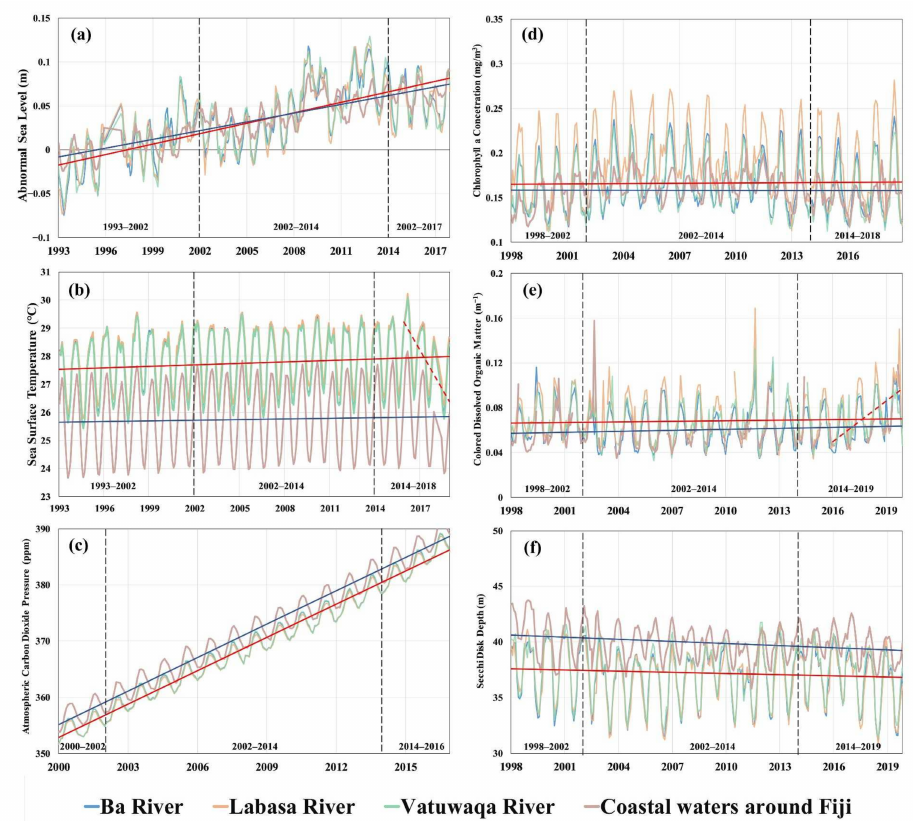
Figure 6. Anomaly chart of long-term variation in water environment parameters: ( a ) Sea-level anomaly; ( b ) Sea-surface temperature; ( c ) Atmospheric carbon dioxide pressure; ( d ) Chlorophyll a concentration; ( e ) Absorption of colored dissolved organic matter; ( f ) Water transparency. The vertical black dotted lines correspond to years 2002 and 2014, respectively. The blue line is the trend line of the coastal waters around Fiji, and the red line is the average trend line of the three estuaries, and the relevant statistics are shown in Table 5. The data in plots ( e , f ) during January 1998 to December 2002 are from SeaWiFS, and the data covering January 2003 to December 2019 are from MODIS. Compared with other periods, the sea-surface temperature of the three estuaries showed a significant decline from January 2016 to December 2018, and colored dissolved organic matter showed a significant upward trend from January 2016 to December 2019. Therefore, in plots ( b , f ), additional red dashed lines are used to characterize the special changing